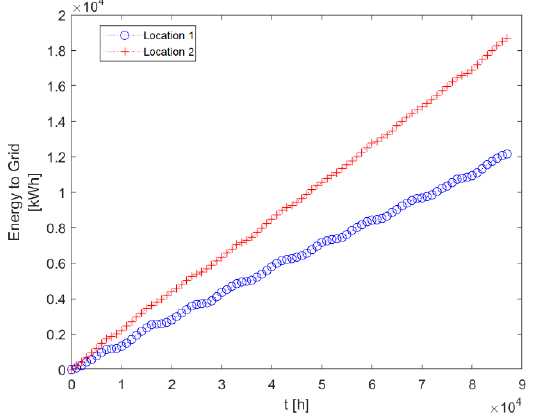
Figure 14. Energy to the grid (PV with battery).